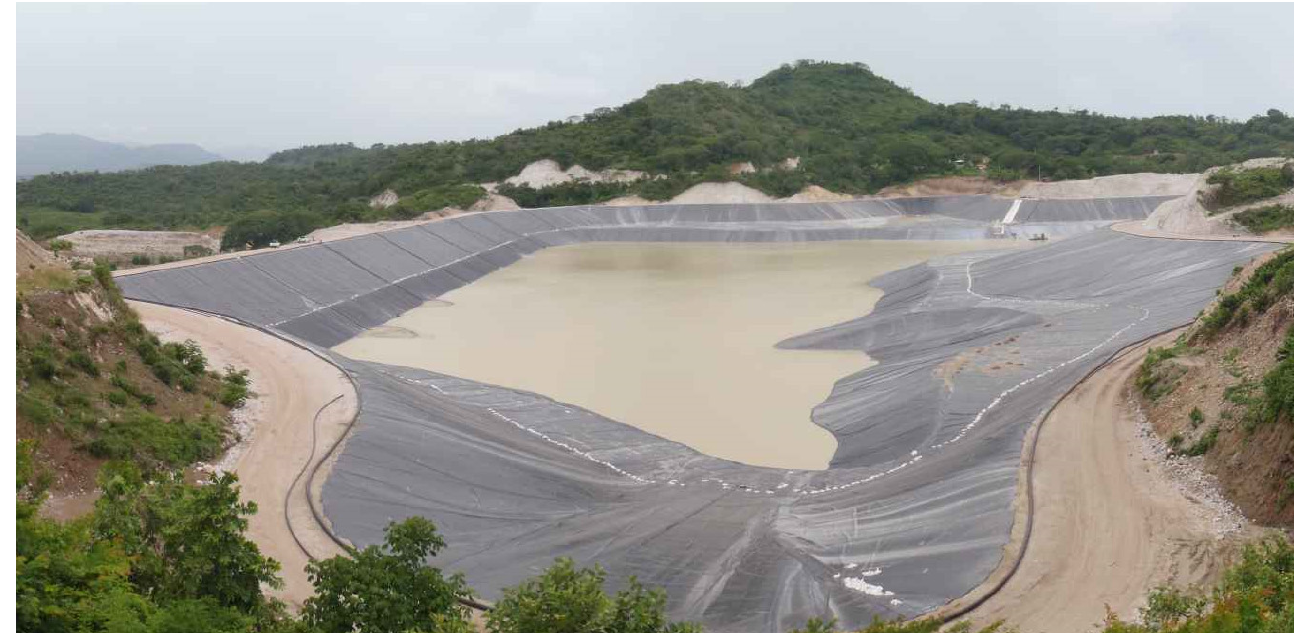
Figure 28. Example of smart geosynthetic with fiber optics technology.